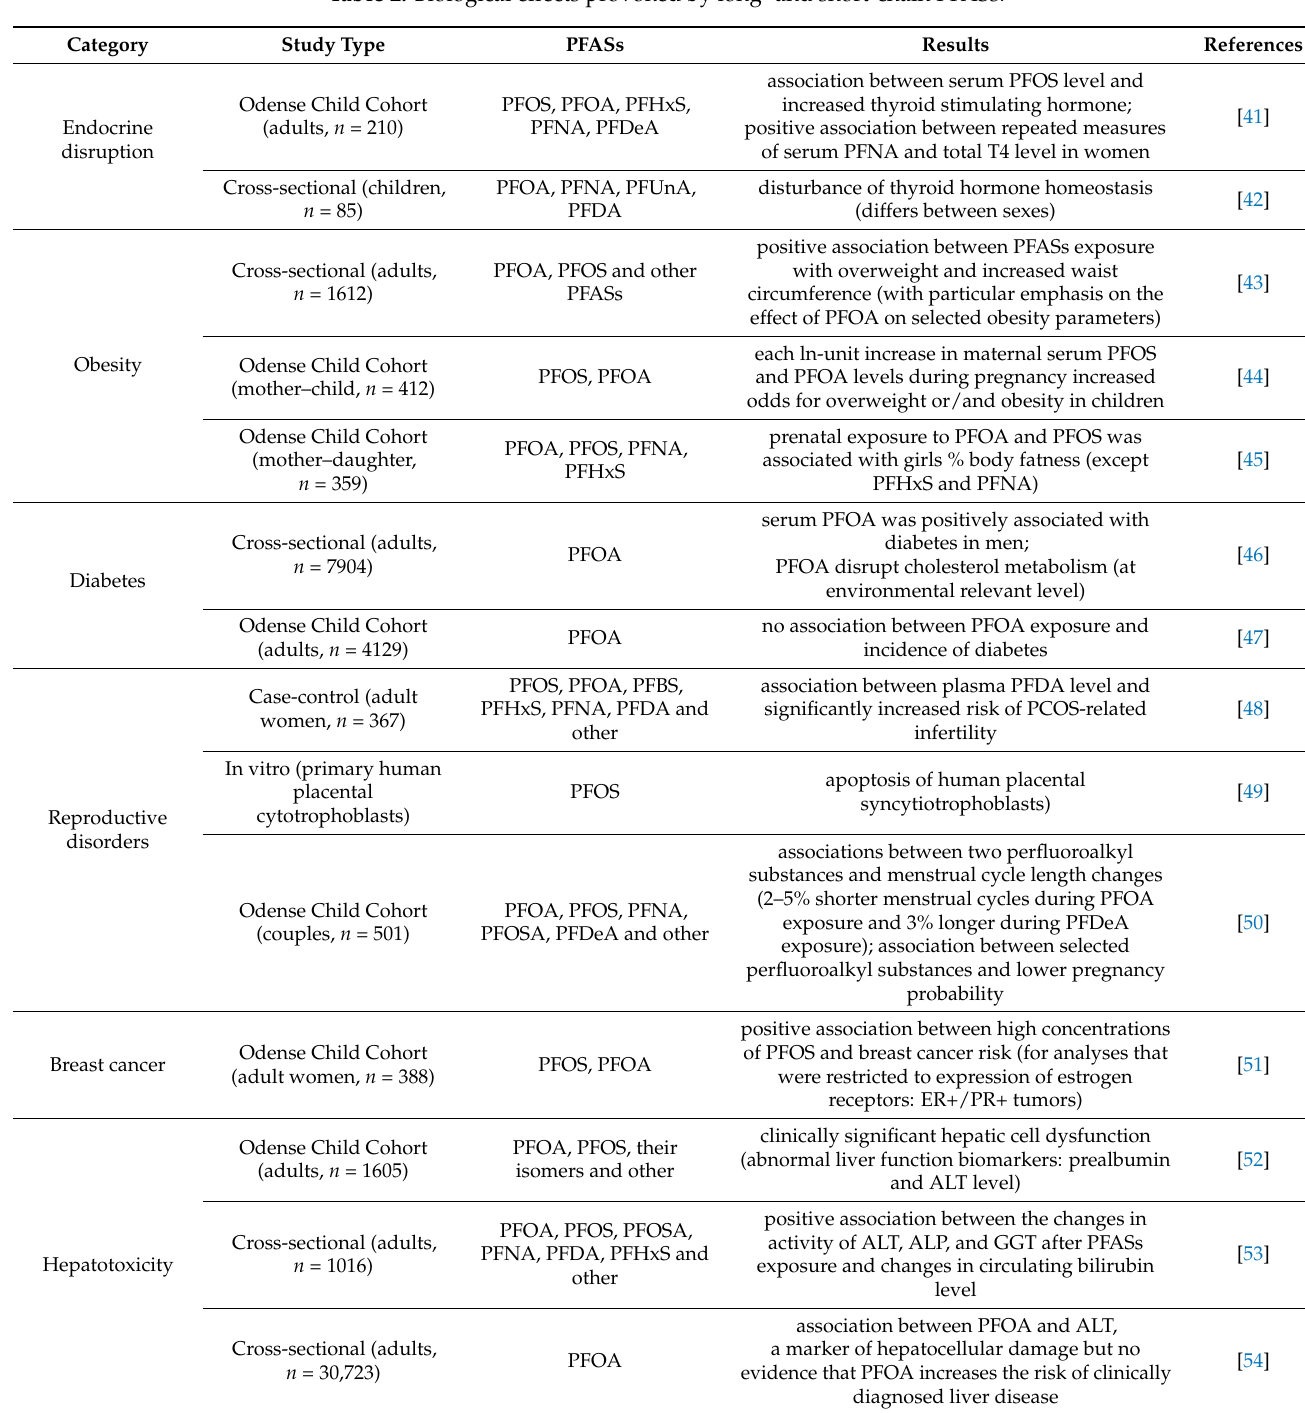
Table 2. Biological effects provoked by long- and short-chain